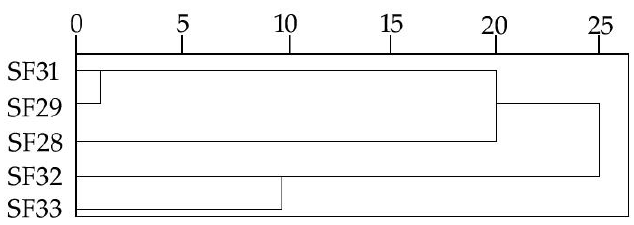
Figure 2. The cluster results of important firm-related factors.